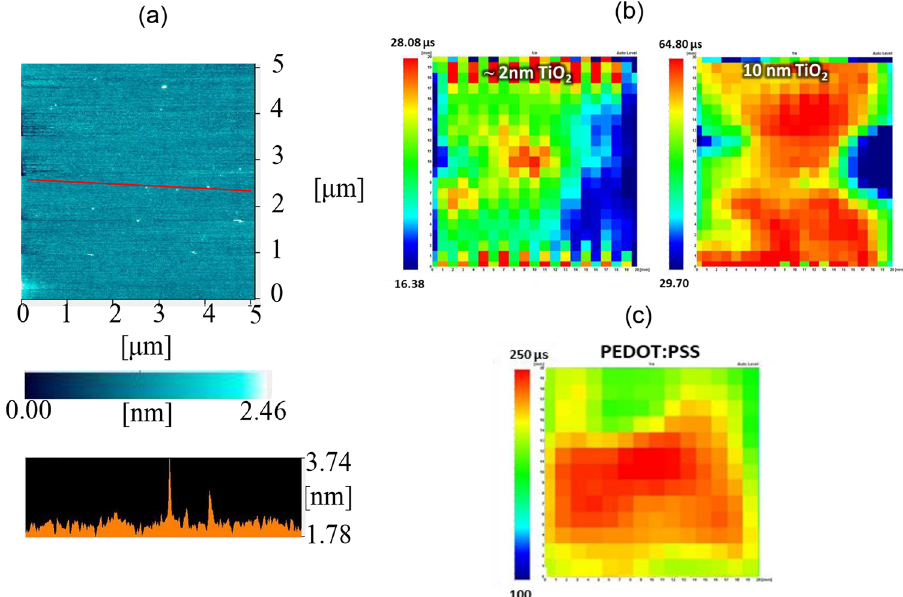
Fig. 3. (a) AFM image and line pro fi le for 2-nm-thick TiO 2 on an n-Si wafer. (b) 2D map of t s for 2- and 10-nm-thick TiO 2 coated on n-Si at both the front and bottom surfaces. (c) 2D map of t s for 80-nm-thick PEDOT:PSS.